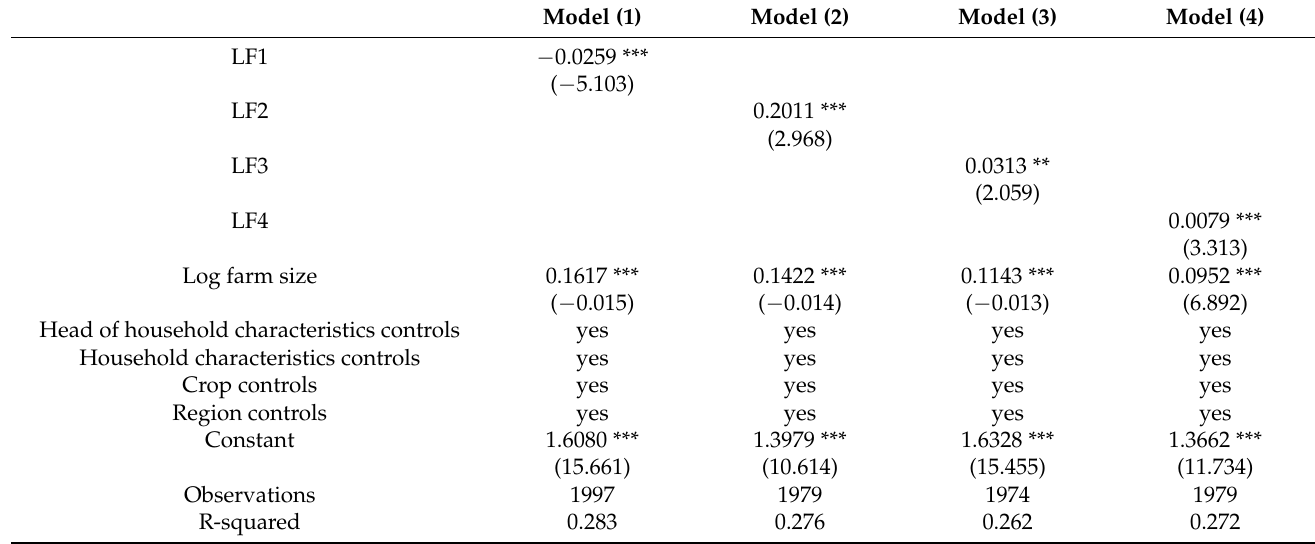
Table 6. Results of LF on ploughing